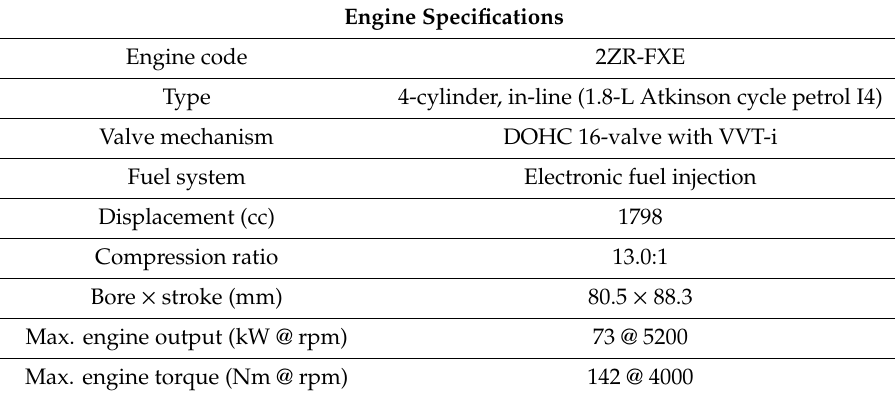
Table 2. Engine Specifications.